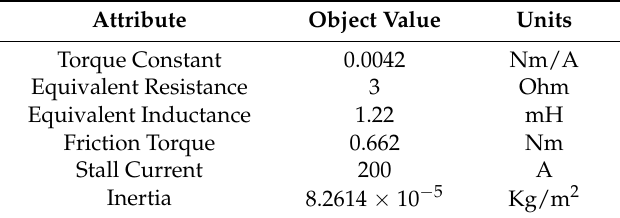
Table 6. Motor/generator specifications.